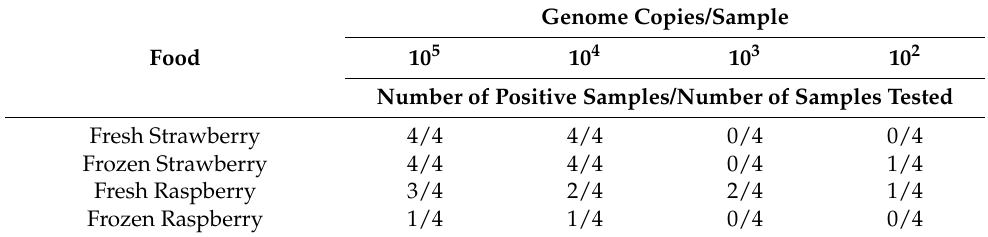
Table 2. Detection of HAV on berries using capture by ApoH beads.